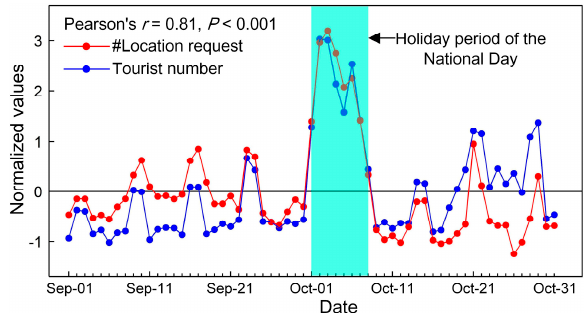
Figure 2. The relationship between the number of location requests derived from Tencent’s big data map and the number of tourists (both were normalized using the standard score) in the ancient town of Qingyan (located in Guiyang City, Guizhou Province, China) over the 61-day period in 2017.